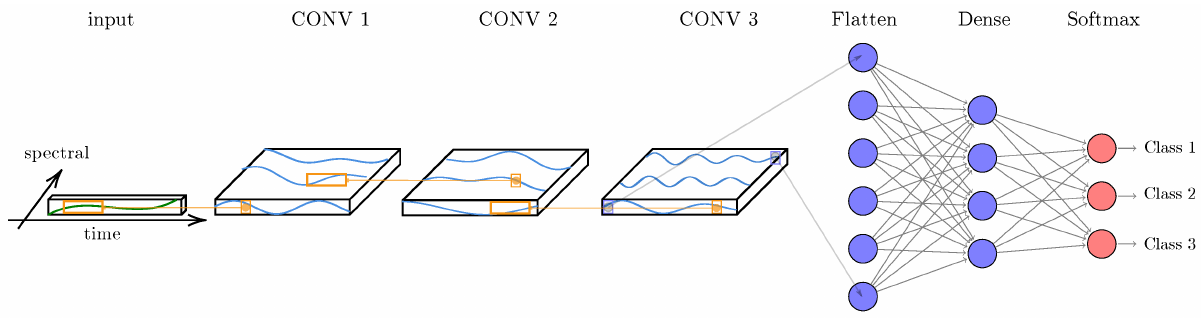
Figure 5. TempCNN architecture according to (Pelletier et al., 2019).